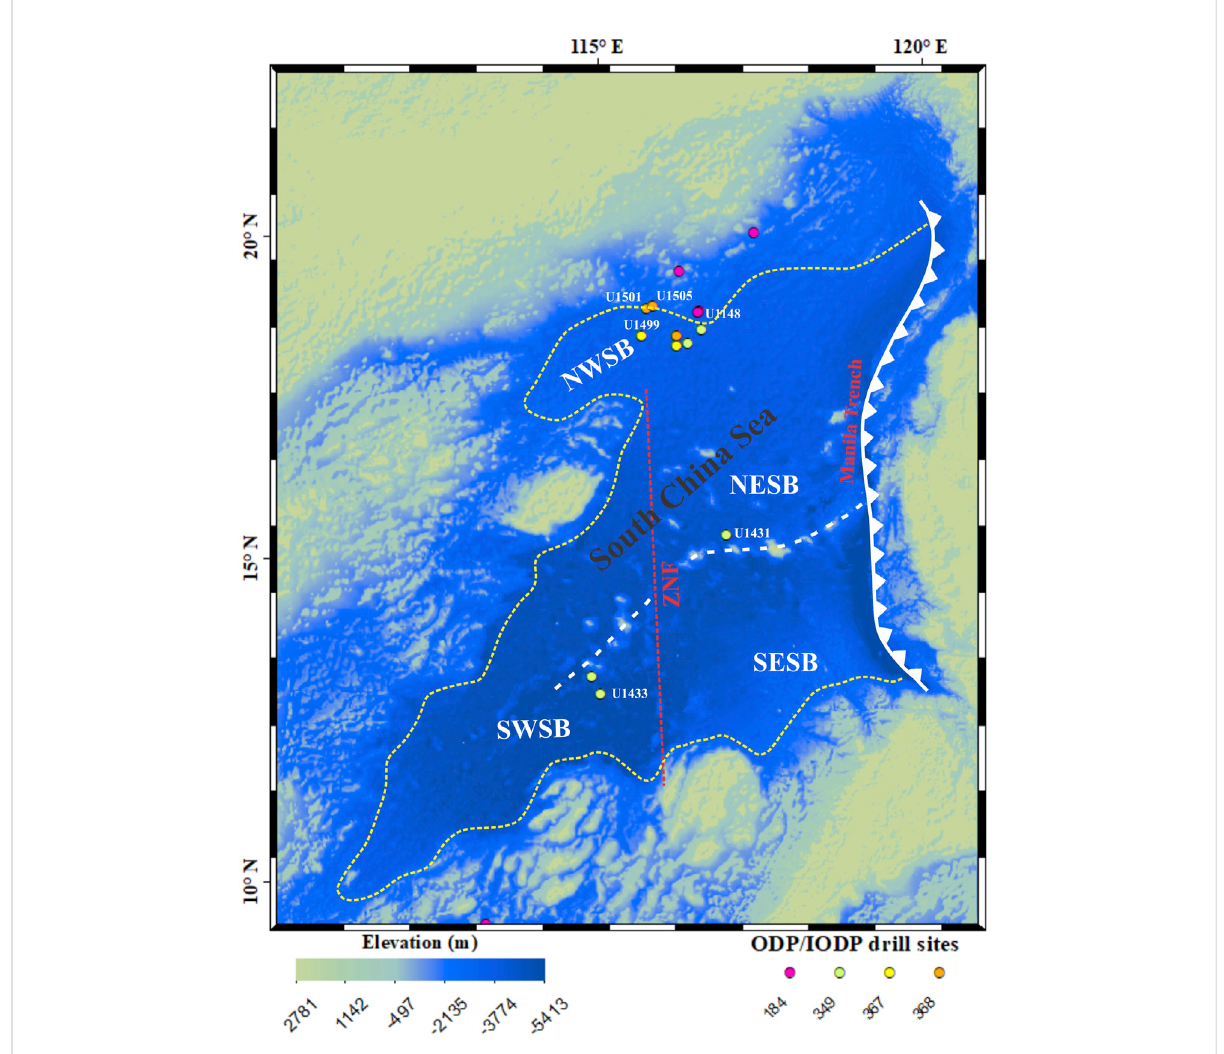
Bathymetric map of the (SCS) area. The solid yellow line indicates the ocean continent boundary whereas the red dashed line indicates the Zhongnan Fault (ZNF). The white dashed line shows the fossil-spreading ridge, while white solid line represent the subduction along the Nansha Trough andtheManilaTrench.The circles indicate thelocationof ODP/IODP sitesused inthisstudy. SWSB isan abbreviation oftheSouthwestSub- basin, NESB, Northeast Sub-basin; SESB, So utheast Sub-basin; NWSB, Northwest